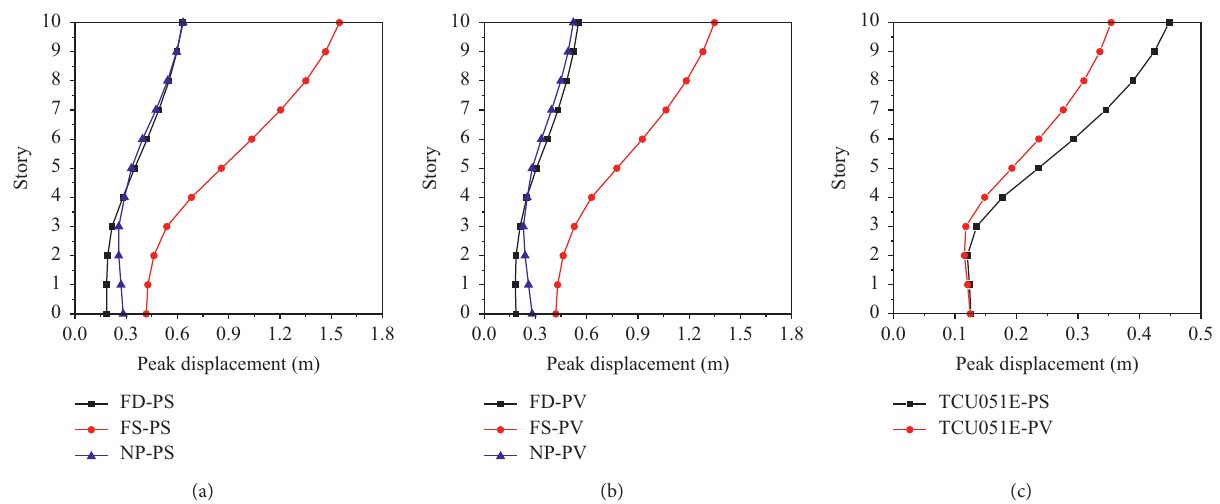
Figure 13: The average peak displacement of the structure under seismic excitations with velocity pulse: (a) the SSI system without viscous dampers; (b) the SSI system with viscous dampers; (c) the ground motion of